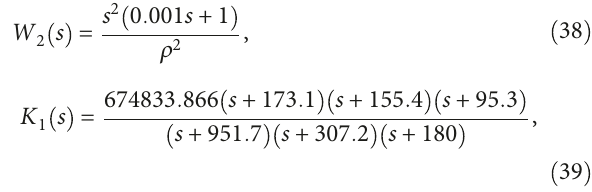
Figure 12: The disturbance attenuation performance of the